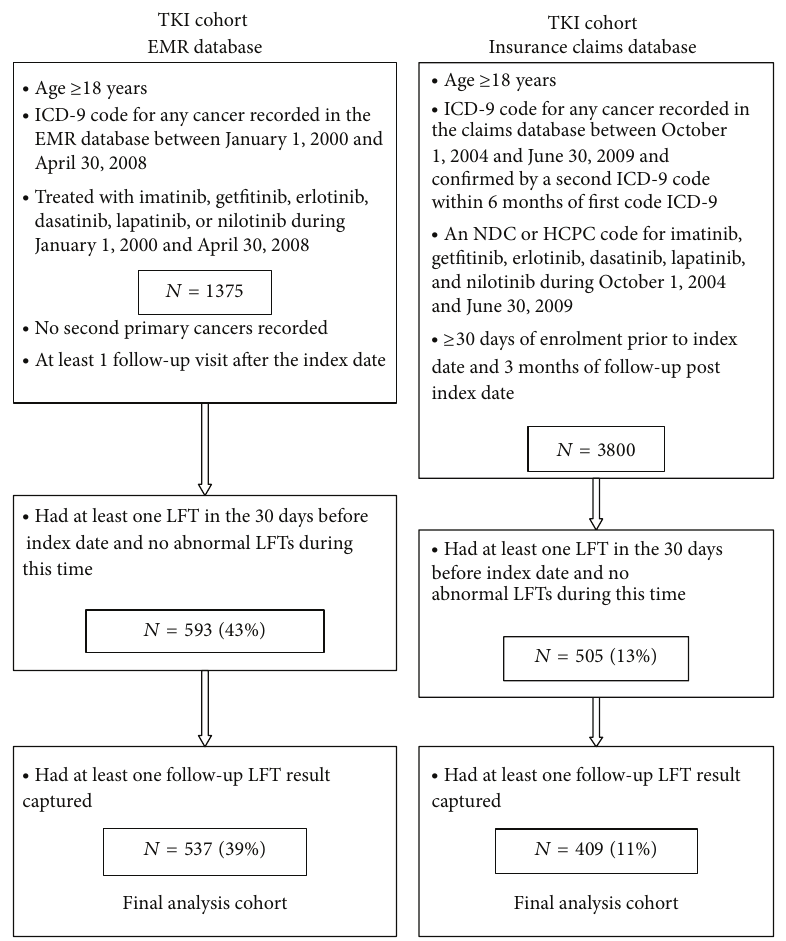
Figure 2: Cohort selection, TKI